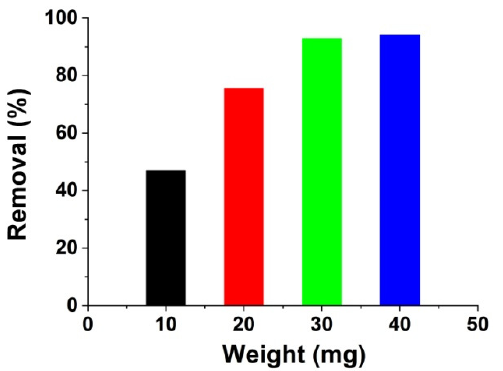
Figure 4. Ni/Zn LDH adsorbent dosage effect on Carmoisine (Az)